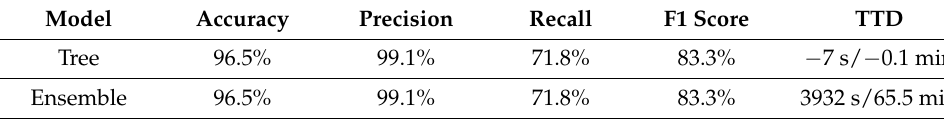
Figure 14. Experiment 2 approach. Table 4. Experiment 2 results.